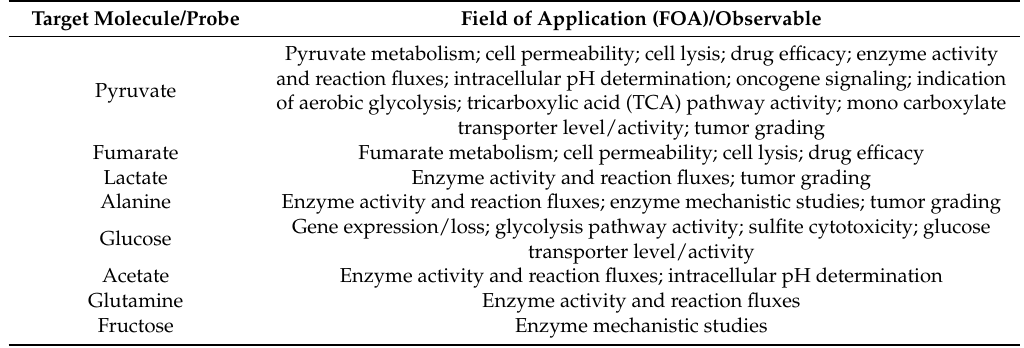
Table 1. Selection of endogenous target molecules used as reporter probes for hyperpolarization- assisted in-cell NMR studies of metabolic processes, together with their associated field(s) of